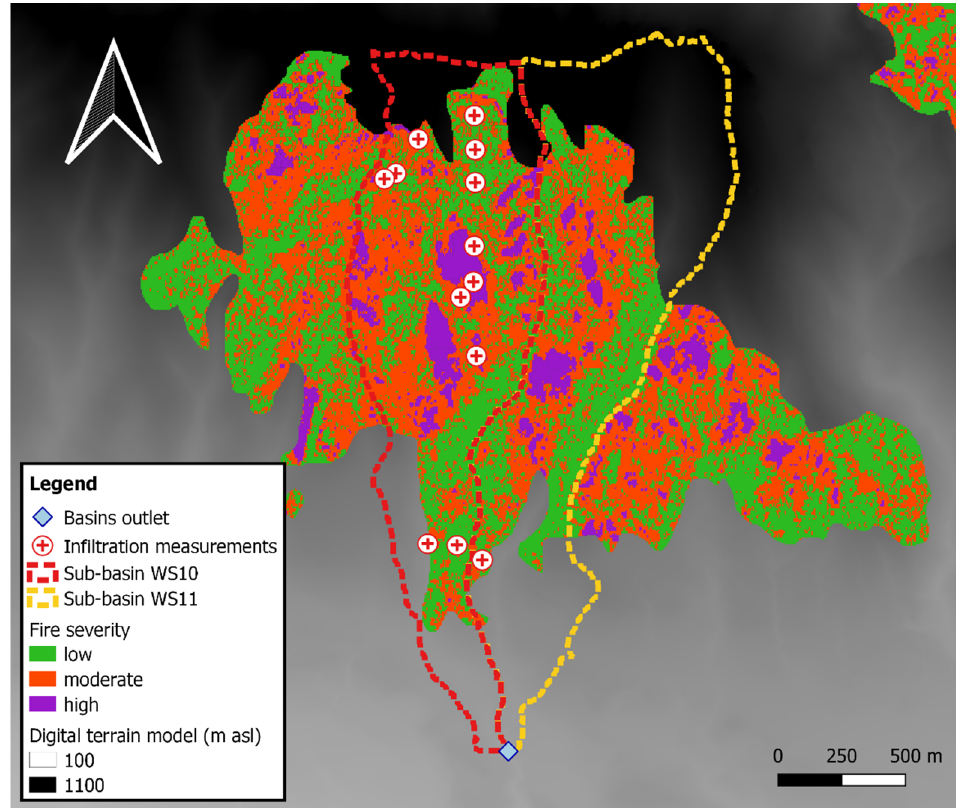
Figure 5. Areas affected by fire, burn severity and position of infiltration measurements.